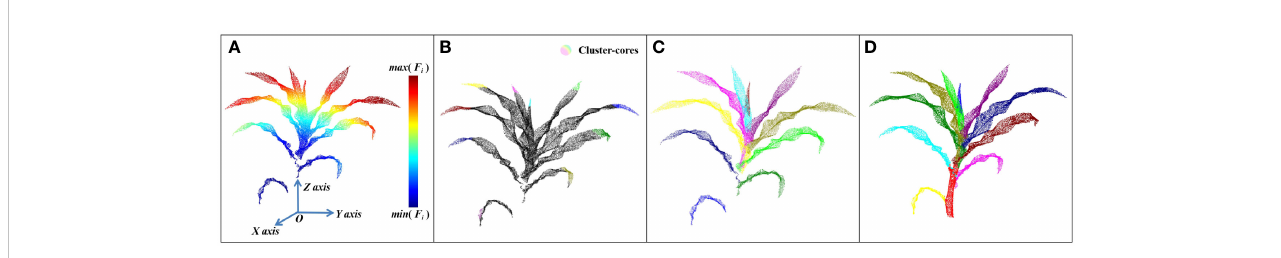
FIGURE 4 The process of leaf segmentation: (A) A thermodynamic diagram of the distance function. (B) Extraction results of leaf Cluster-cores. (C) Result of leaf instance segmentation. (D) Result of stem and leaf